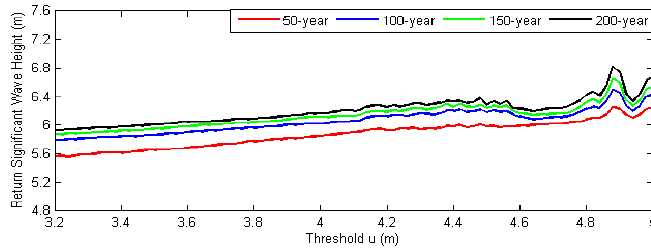
Figure 7. Sensitivity of the return significant wave heights to the thresholds (3.2–5.0 m) at location